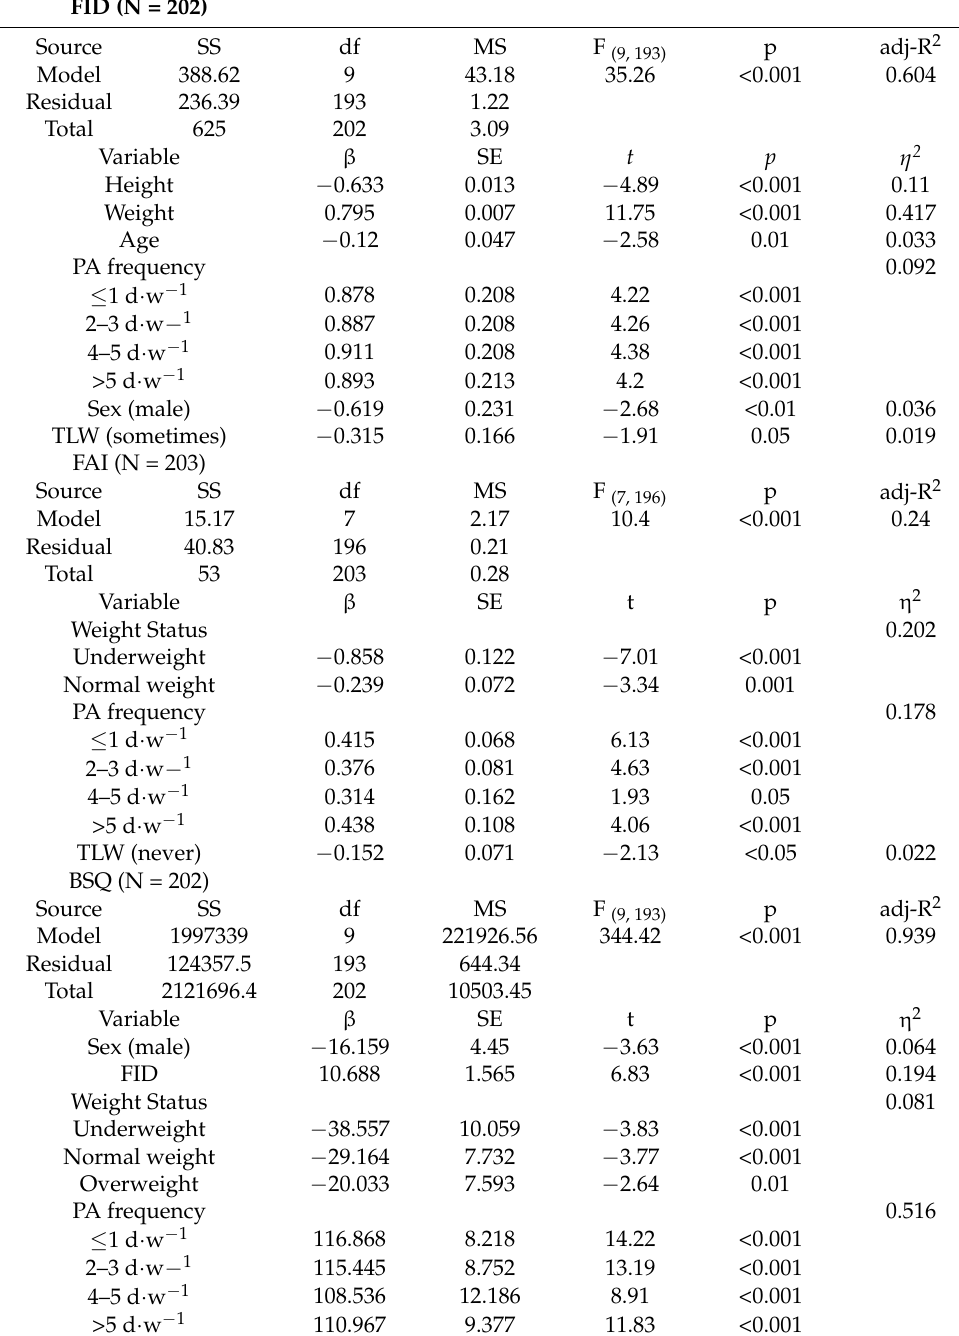
Table 3. Predictors of FID, FAI, and BSQ: multiple regression analysis